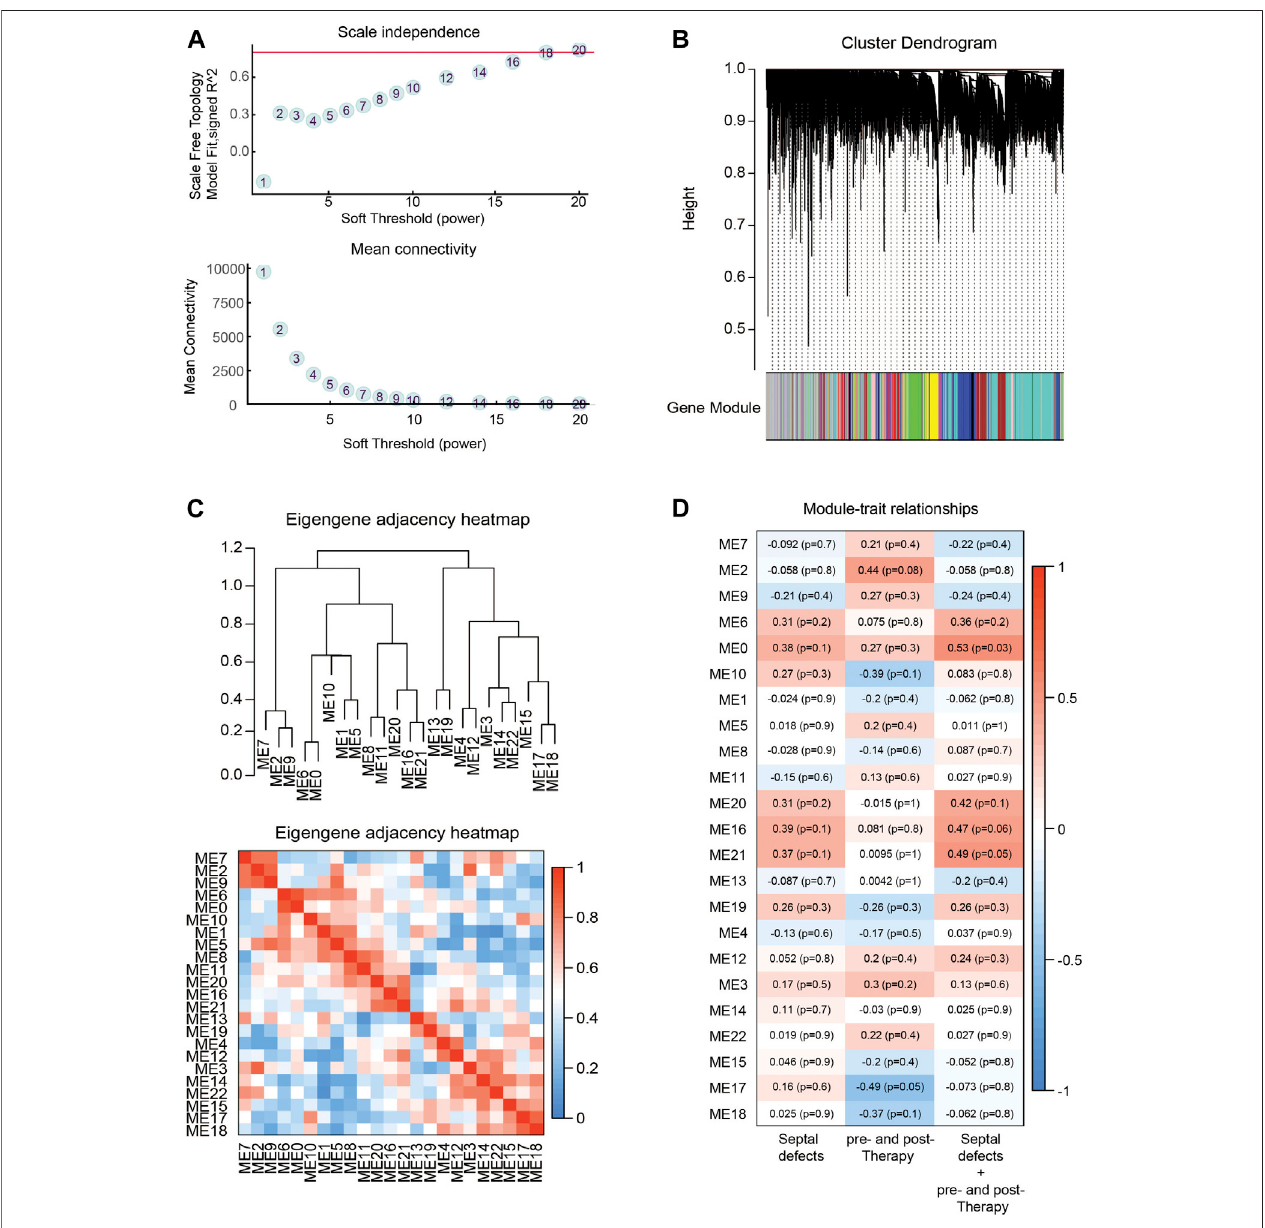
FIGURE 4 | Identi fi cation of key modules through WGCNA. (A) Analysis of the scale-free fi t index (up) and the mean connectivity (down) for various soft- thresholding powers. (B) Eigengenes adjacency heatmap. (C) Dendrogram of all DEGs clustered based on a dissimilarity measure (1-TOM). (D) Heatmap of the correlation between module eigengenes (ME) and traits of septal defects or therapy. Each grid of the heatmap contains the correlation coef fi cient and p -value.